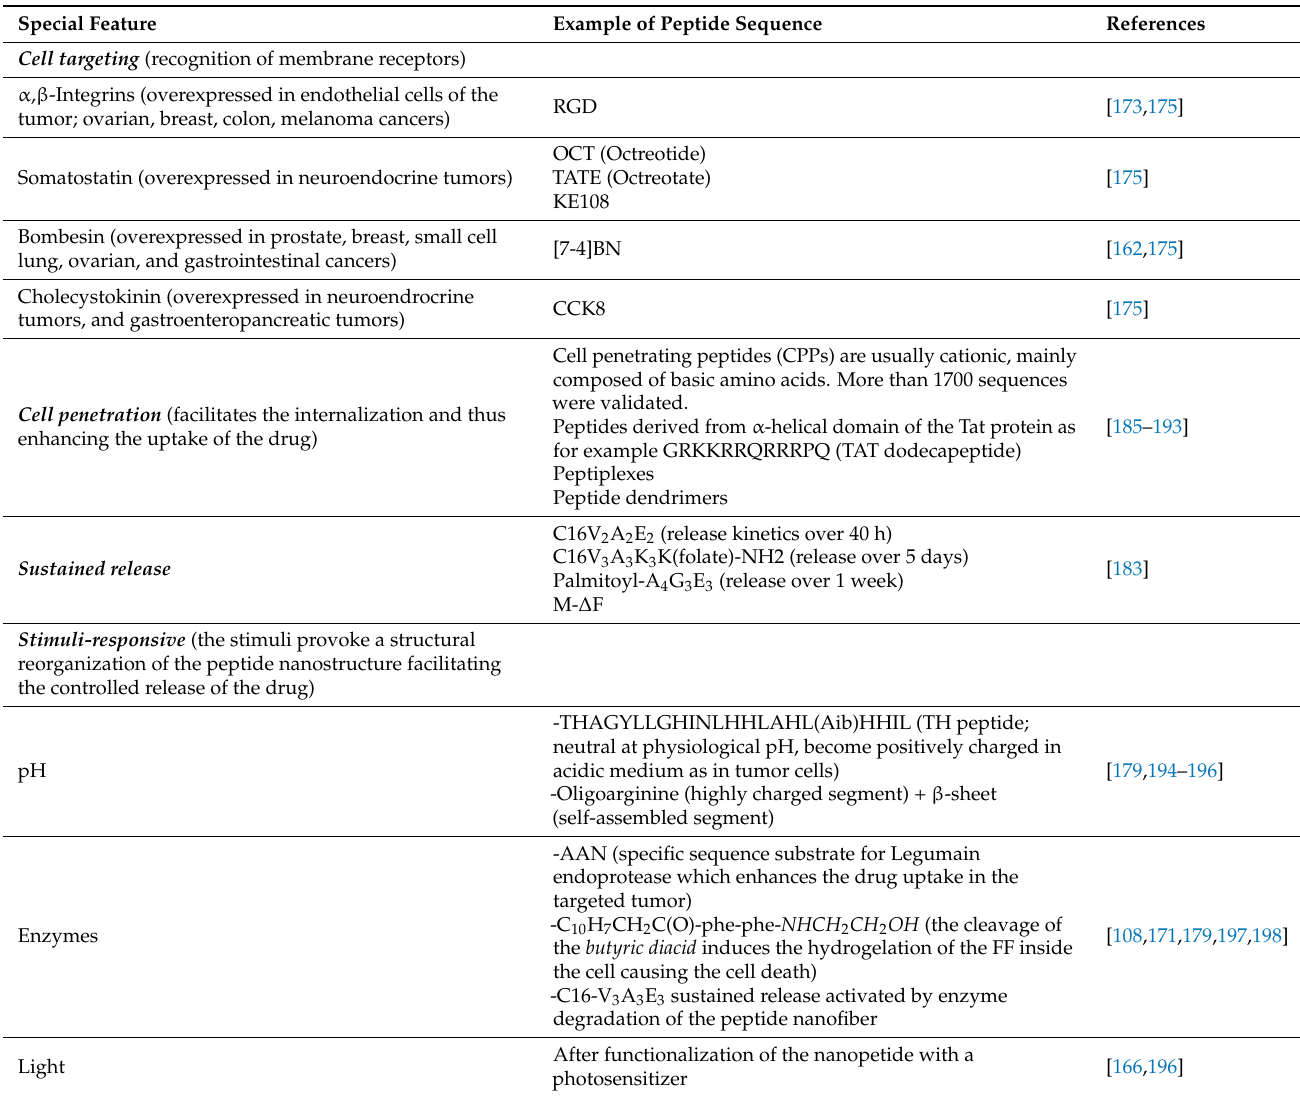
Table 1. Some examples of specific peptide sequences that introduce special features for drug delivery and biological